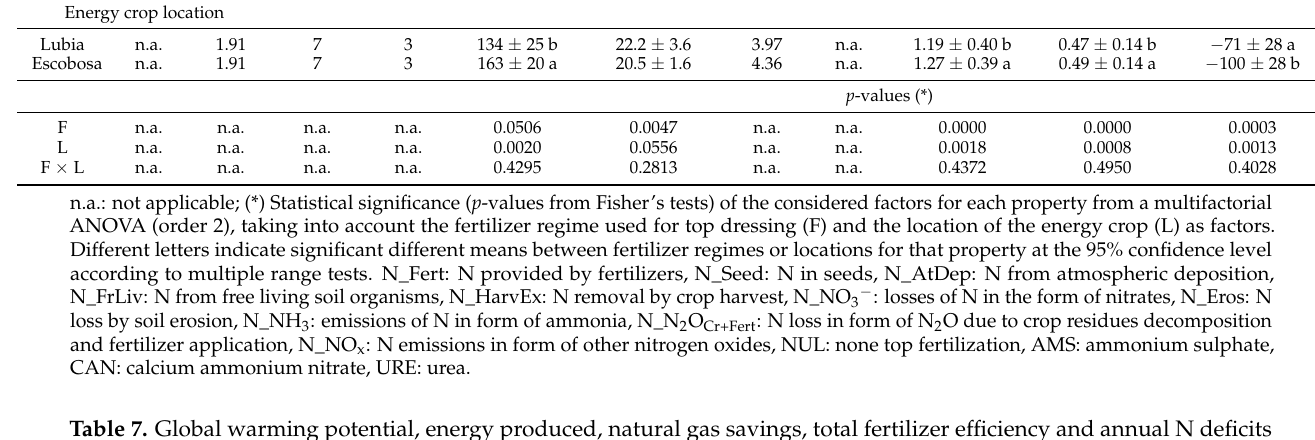
Table 7. Global warming potential, energy produced, natural gas savings, total fertilizer efficiency and annual N deficits (means ± standard deviations) depending on the N fertilizer type used for top dressing and